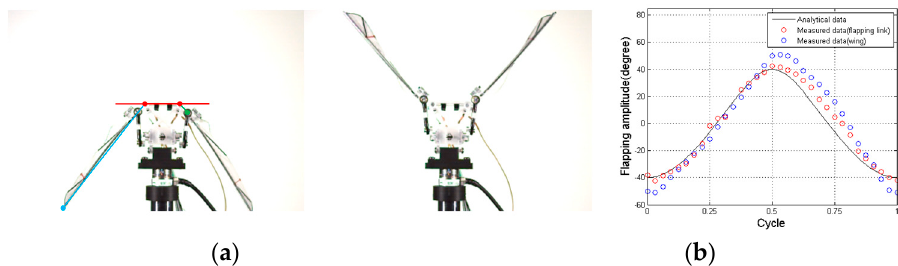
Figure 16. ( a ) Flapping amplitude image of prototype; ( b ) flapping amplitude comparison between designed and measured value.